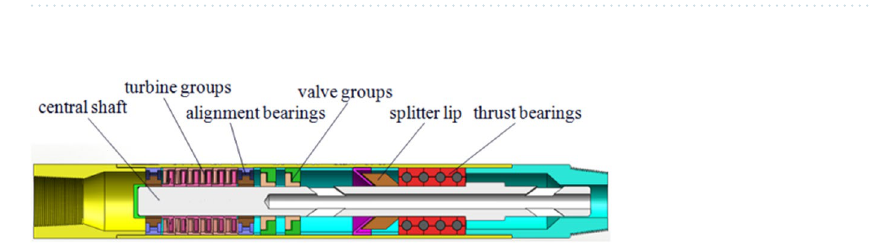
Figure 1. The oscillation section of oscillator.